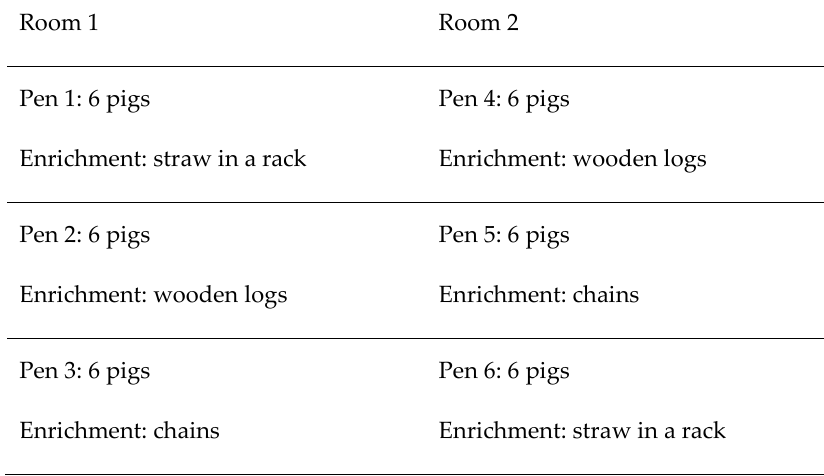
Figure 1. Distribution of di ff erent types of enrichment